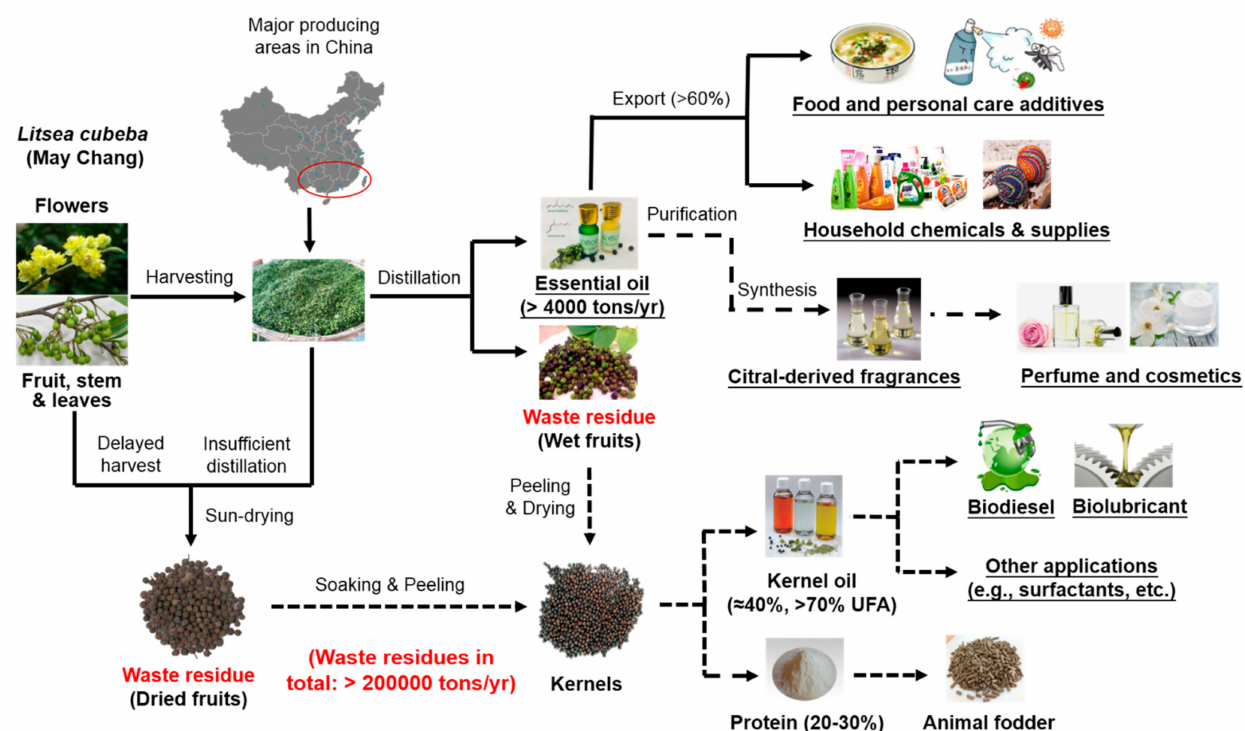
Figure 1. Sustainable biorefinery to produce plant-based products from Litsea cubeba (solid line: high technical maturity, half dashed line: medium technical maturity, full dashed line: low technical